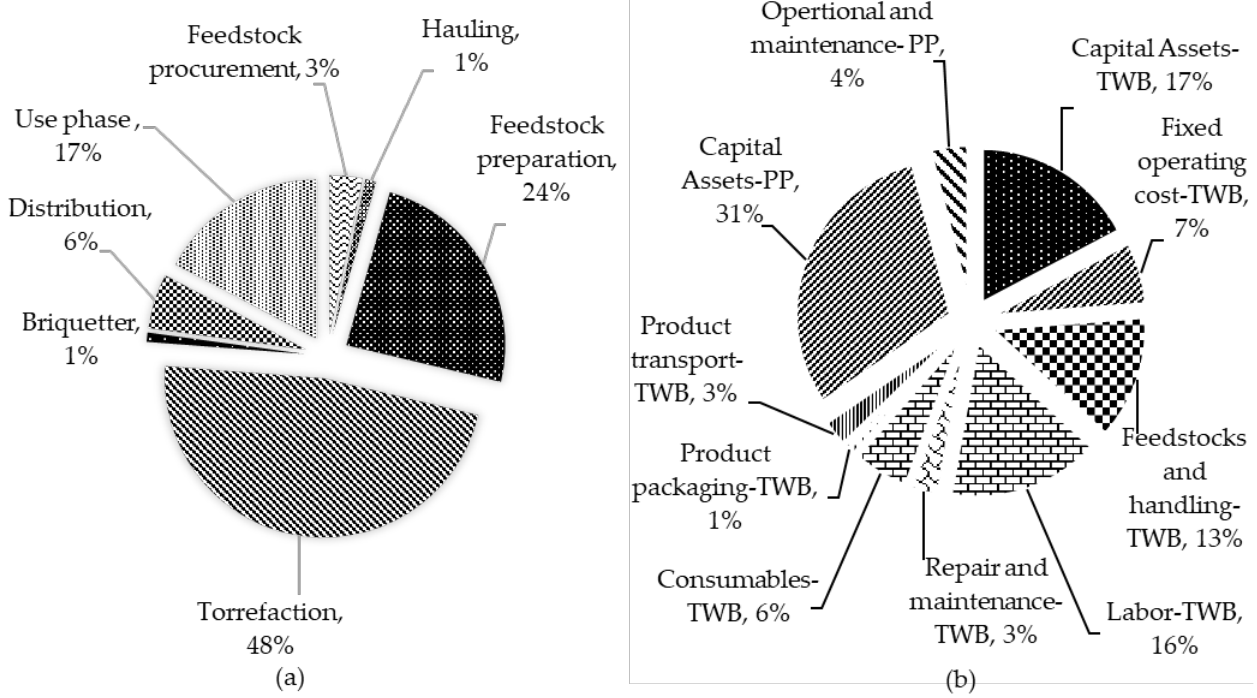
Figure 5. Contribution of processes or inputs to the ( a ) overall global warming potential, and ( b ) cost of 1 kWhe generated from torrefied wood briquettes (TWBs) in the power plant (PP).